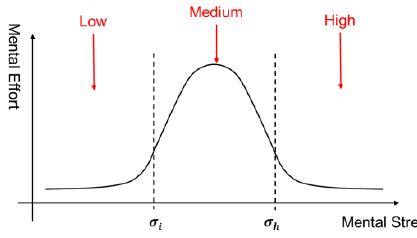
Figure 1. Mental Stress-Effort Model [111].